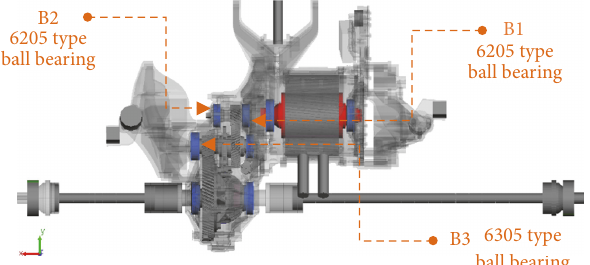
Figure 3: Illustration of the faulty test bearings, namely, B1, B2, and